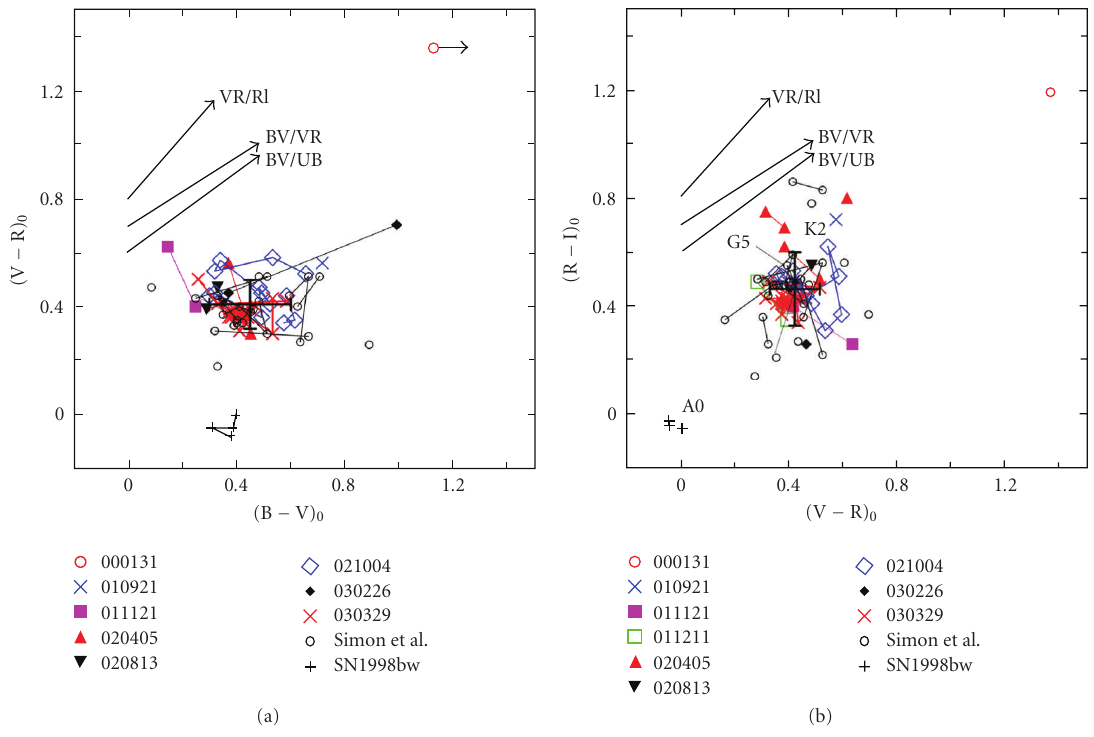
Figure 2: Examples of the color diagrams of opticl afterglows (OAs) of GRBs. The data for t − T 0 < 10.2 d in the observer frame and corrected for the Galactic reddening are displayed. Multiple indices of the same OA are connected by lines for convenience. The mean colors (centroid) of the whole ensemble of OAs (except for GRB000131 and SN 1998bw) are marked by the large cross. The representative reddening paths for E B − V = 0.5 and positions of the main-sequence stars are also shown. Adapted from [9–11].